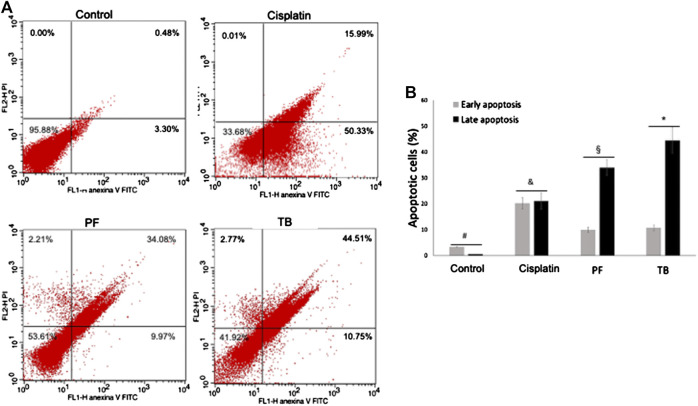
Apoptosis of HCT15 cells after 48 h of exposure to the polyphenolic fraction and thalassiolin B obtained from T. testudinum extract (at IC50 values). (A) Representative histogram of flow cytometry analysis by annexin V-FITC/propidium iodide staining. (B) Analysis of the percentage of apoptotic cells in each group. Cisplatin (10 µM) was used as positive control. PF, polyphenolic fraction; TB, thalassiolin (B). Bars represent the mean ± standard deviation of two independent experiments by triplicate. Different symbols represent statistical differences between groups (one-way ANOVA, followed by Tukey post-hoc test, p < 0.05).